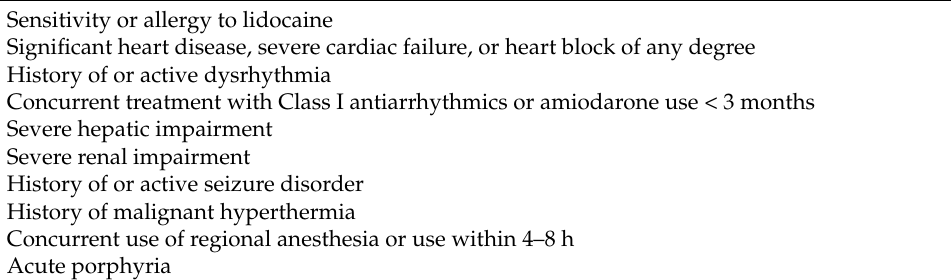
Table 2. Contraindications for systemic lidocaine